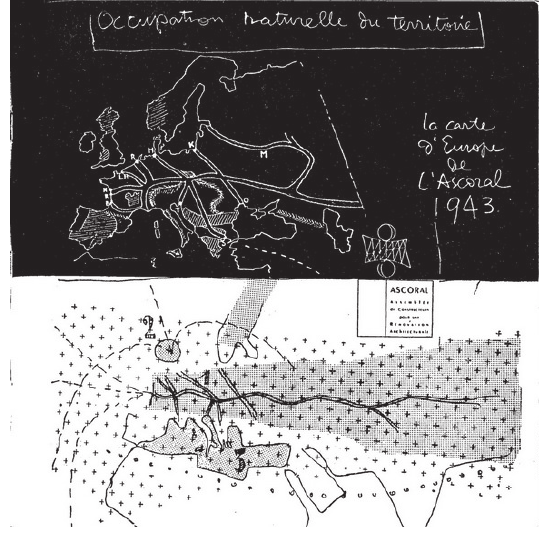
Fig. 11. Le Corbusier. Urbanisme des trois établissements humains (1945). ASCORAL European Chart. New guidelines for the euroopean